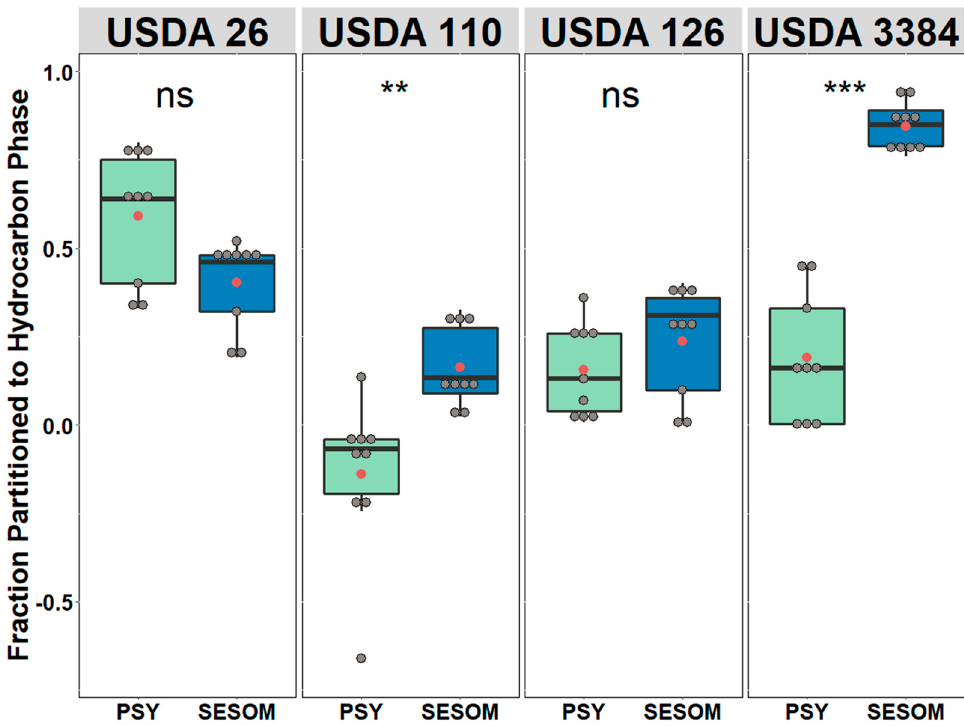
Figure 1. Surface hydrophobicity of Bradyrhizobium strains cultured in either PSY-Arabinose or SESOM to mid exponential phase and partitioned into hexadecane as an apolar solvent. Data were analyzed by Student t-test, and p values indicate statistical significance (ns not significant, ** p < 0.01, *** p < 0.001).